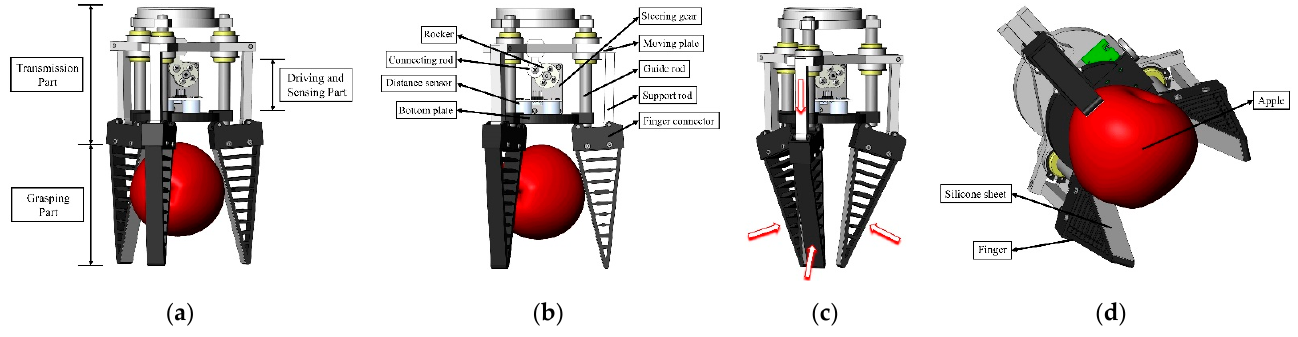
Figure 4. Overall design of the soft gripper: ( a ) overall structure; ( b ) details of transmission and the driving and sensing part; ( c ) the designed gripping mechanism; ( d ) details of the grasping part. In the grasping part, three Fin-Ray finger units are evenly distributed around the bottom plate of the gripper disc, connected with the transmission mechanism by the finger connectors to drive the Fin Ray fingers. A silicone pad is attached to the surface of each finger to increase the contact friction between the finger and the fruit, which ensures the clamping stability, as shown in Figure 4d.